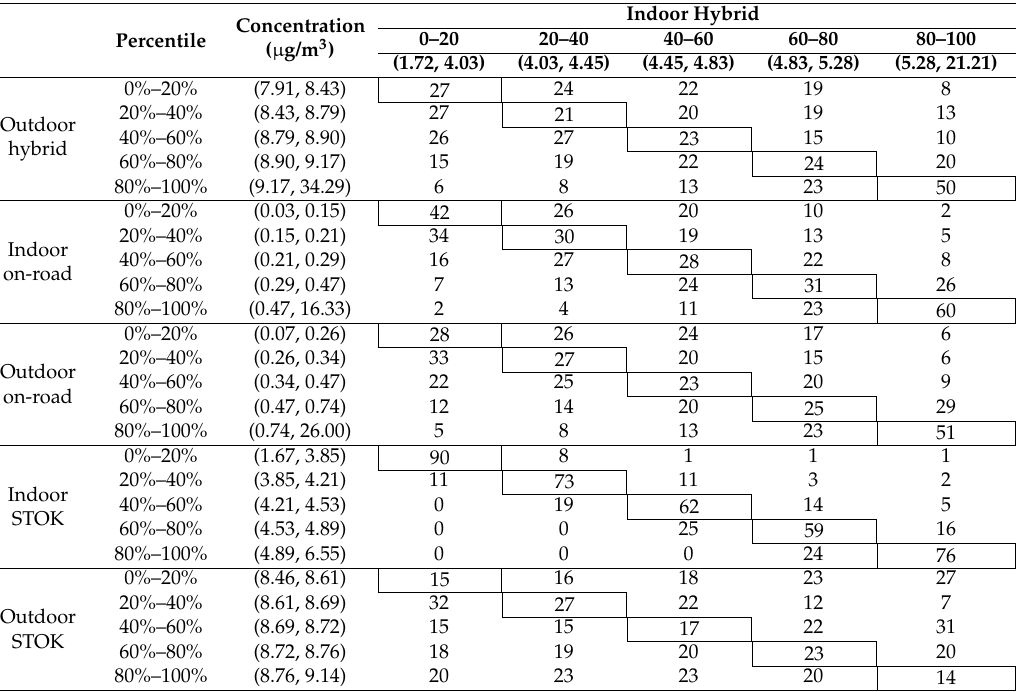
Table 5. Contingency table for PM 2.5 showing agreement between exposure quintiles. The values represent percentage of Census blocks in each quintile. Concentration ranges are shown in parentheses. Boxed percentages along diagonals would be 100% for a perfect